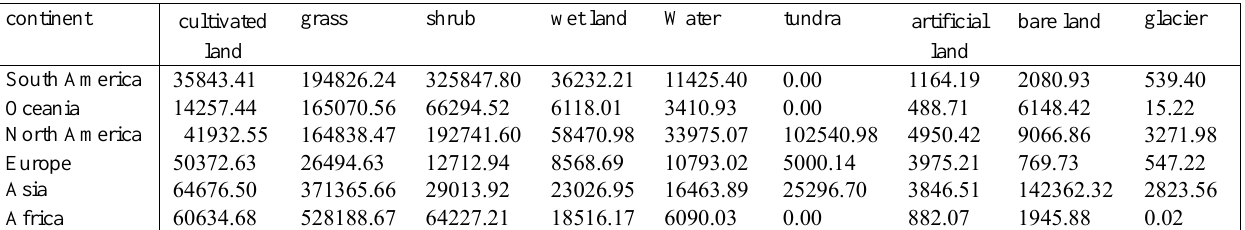
Table4 ： Area that other lands transferred to forest (unit: km 2